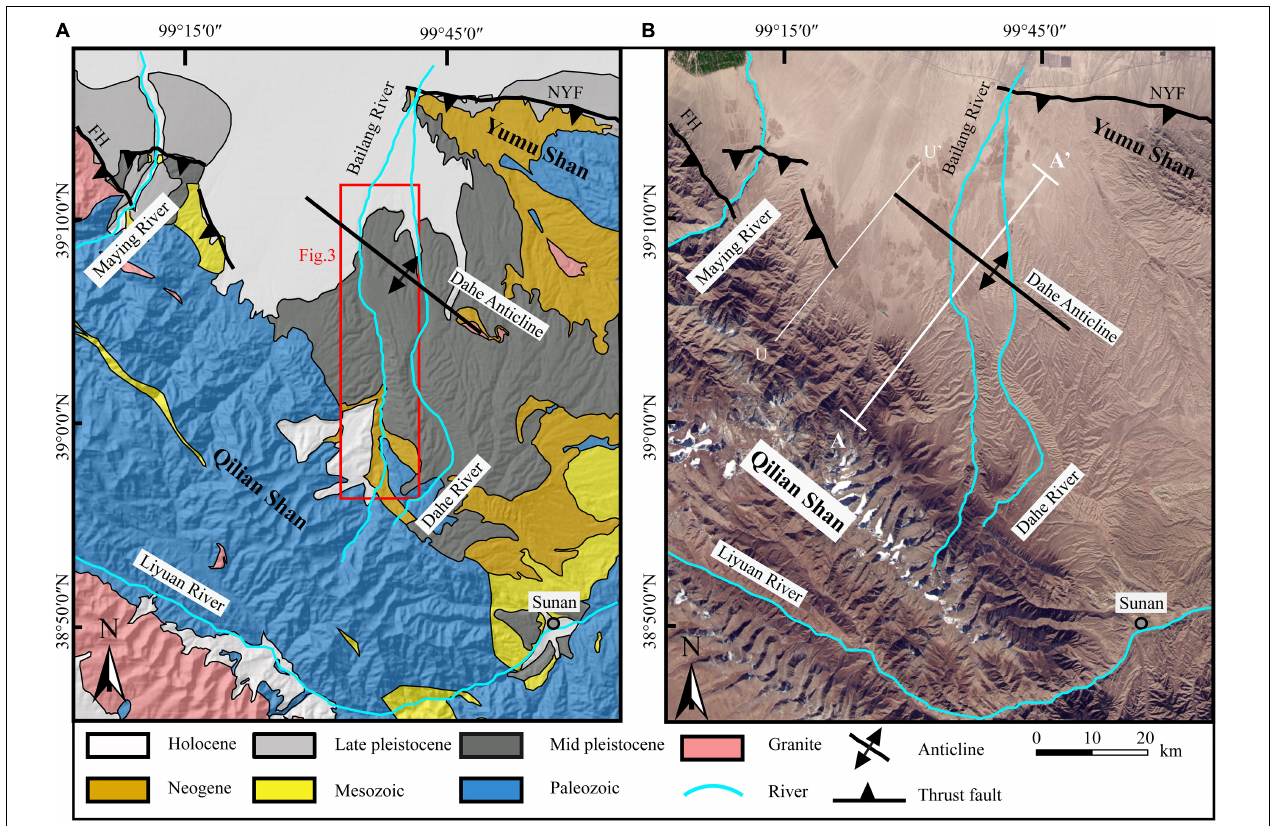
FIGURE 2 | (A) Geologic map of the study region showing the lithology and active structures (lithology data are from 1:200,000 Chinese geologic maps, Ministry of Geology and Mineral Resources). (B) The Google Earth image of the study region showing the topography distribution from the Qilian Shan to the Yumu Shan. The line U–U (cid:48) shows the location of a seismic reflection profile in Zuza et al. (2016). FH is the Fodongmiao-Hongyazi Fault and NYF is the North Yumu Shan Fault, and both of these two faults are parts of the North Qilian Shan Fault